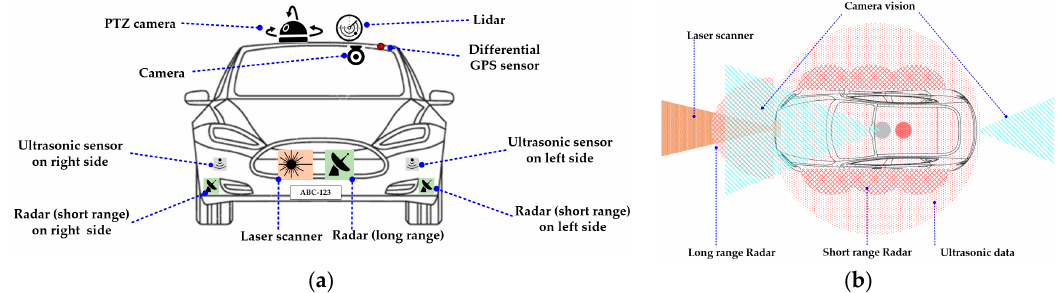
Figure 5. Sensors on a vehicle ( a ) typical location of sensors; ( b ) the working field of various sensors (the two pictures are for description purpose and do not correspond to one another).